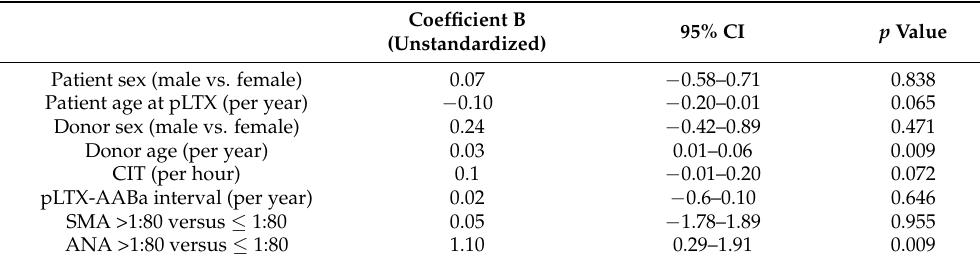
Table 7. Characteristics associated with ISHAK fibrosis score (0–6) in multiple linear regression for ANA and SMA Titer >1:80 versus ≤ 1:80 (n =